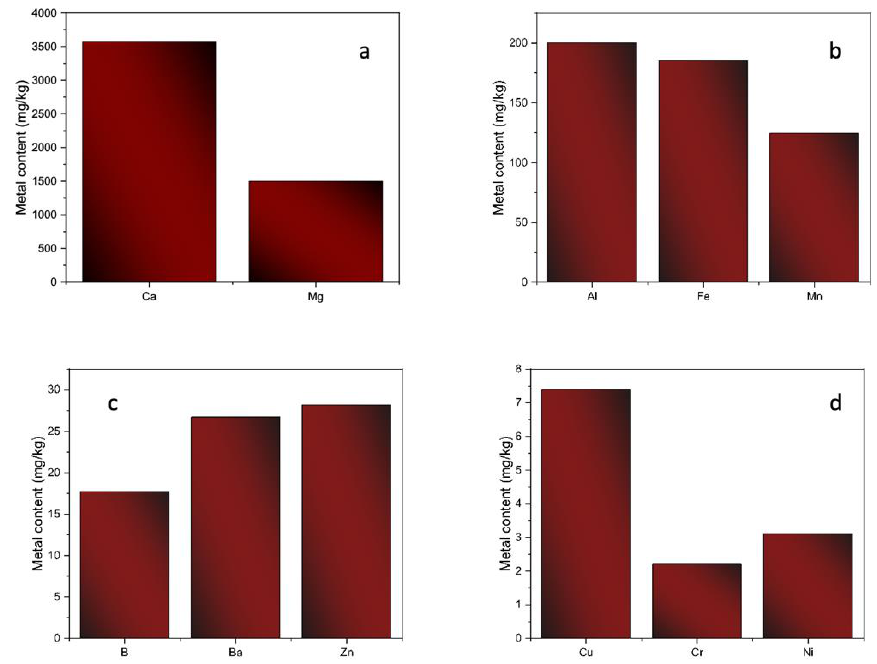
Figure 1. Average metal content for ( a ) Ca and Mg, ( b ) Al, Fe and Mn, ( c ) B, Ba and Zn and ( d ) Cu, Cr and Ni in the spice samples. Table 4. Comparison of the elemental composition of spices found in this study with reported composition of other